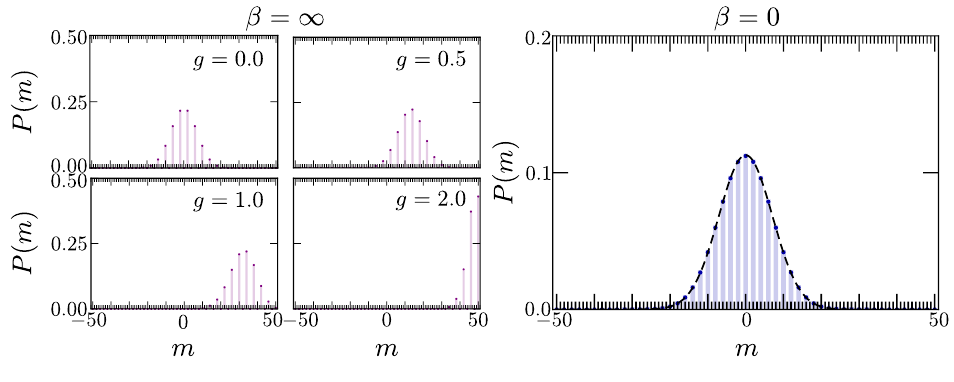
Figure 11: Limiting cases of transverse magnetization distribution. Probability distribution of the transverse magnetization P ( m ) as a function of the magnetic field g and inverse temperature β for a chain of L = 50 spins. The left panel shows the ground-state transverse magnetization distribution for different values of the mag- netic field, and is computed using the characteristic function Eq. (106). The right panel shows the transverse magnetization distribution at infinity temperature, ob- tained using the characterization function given by Eq. (107). The envelope of the distribution is reproduced by the Gaussian approximation N ( 0, L ) shown as a dashed black